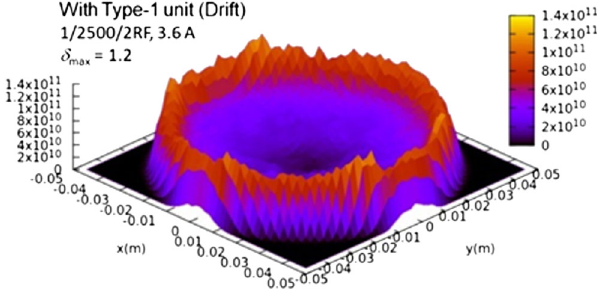
FIG. 8. Simulation result of the electron density in a beam pipe with a type-1 unit for a beam current of 3.6 A at a bunch fill pattern of 1 = 2500 = 2 RF.